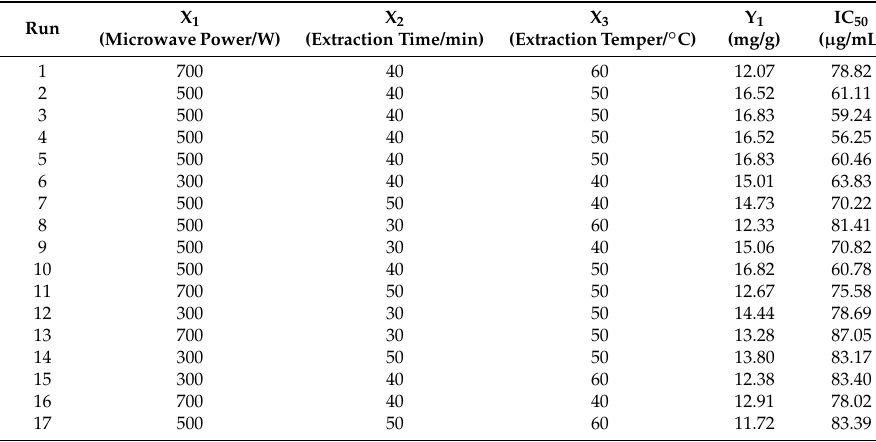
Table 6. The results of experiment